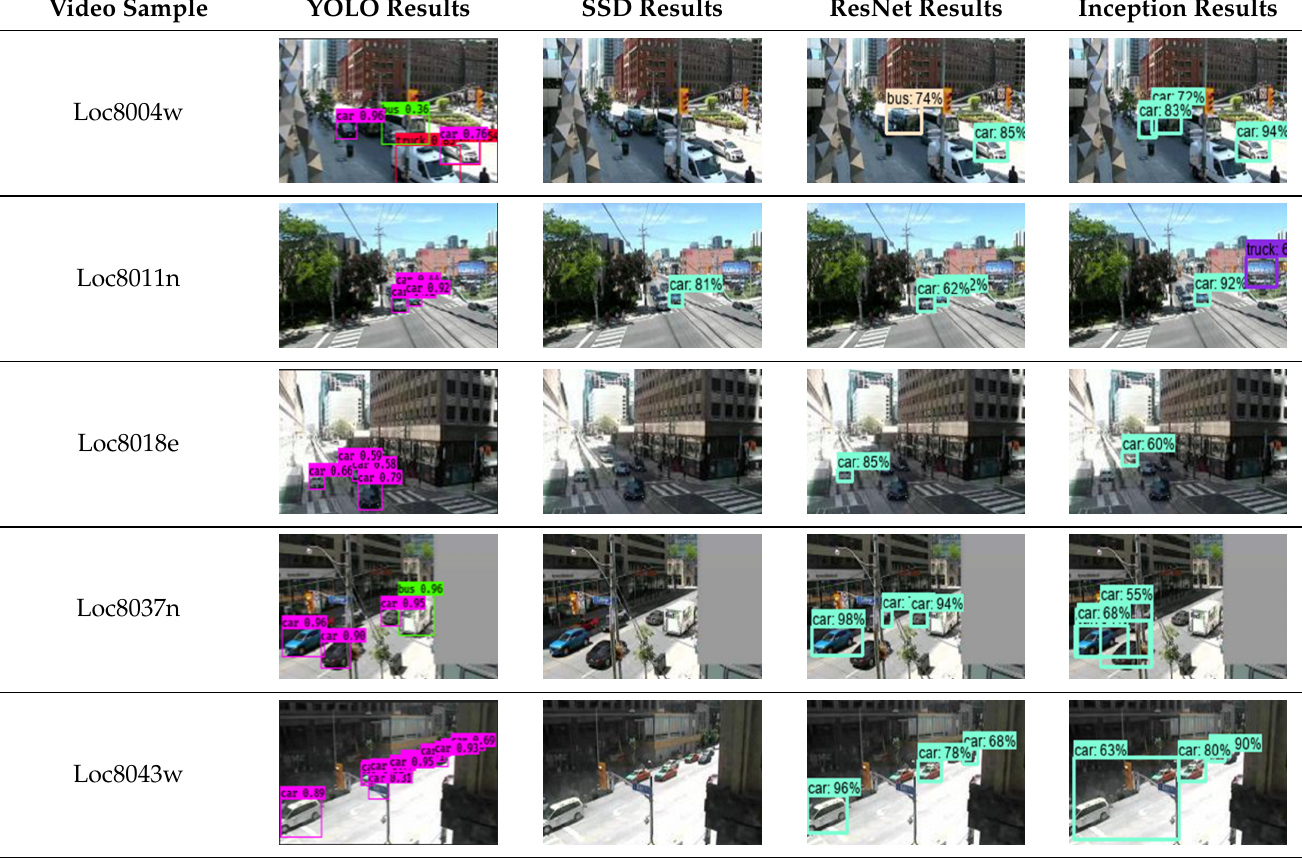
Table A2. Comparison of vehicle detection models on selected traffic camera images obtained from Toronto Open Data. Cars, buses and trucks marked as purple/cyan, green/beige and red colors